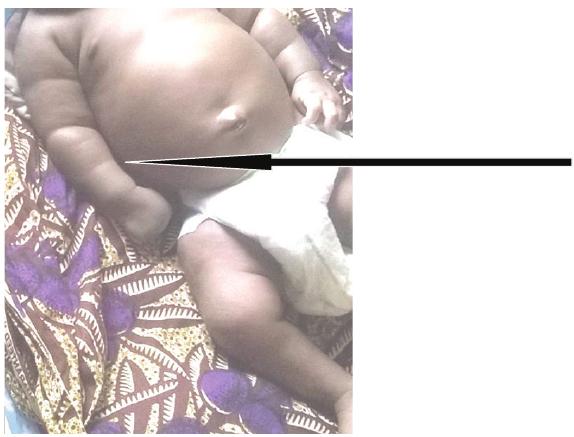
Figure 4: General regression in nodules and limb sizes noted at 9th week of life during emergency admission.